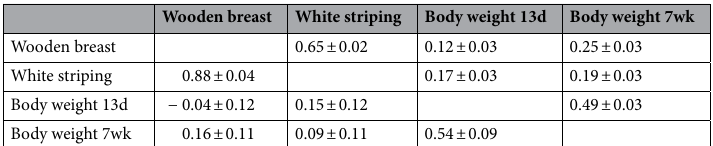
Table 2. Estimates (± SE) of phenotypic (above diagonal) and genetic (below diagonal) correlations among wooden breast, white striping, and body weight at 13 days and at 7 weeks of age based on bivariate analyses.